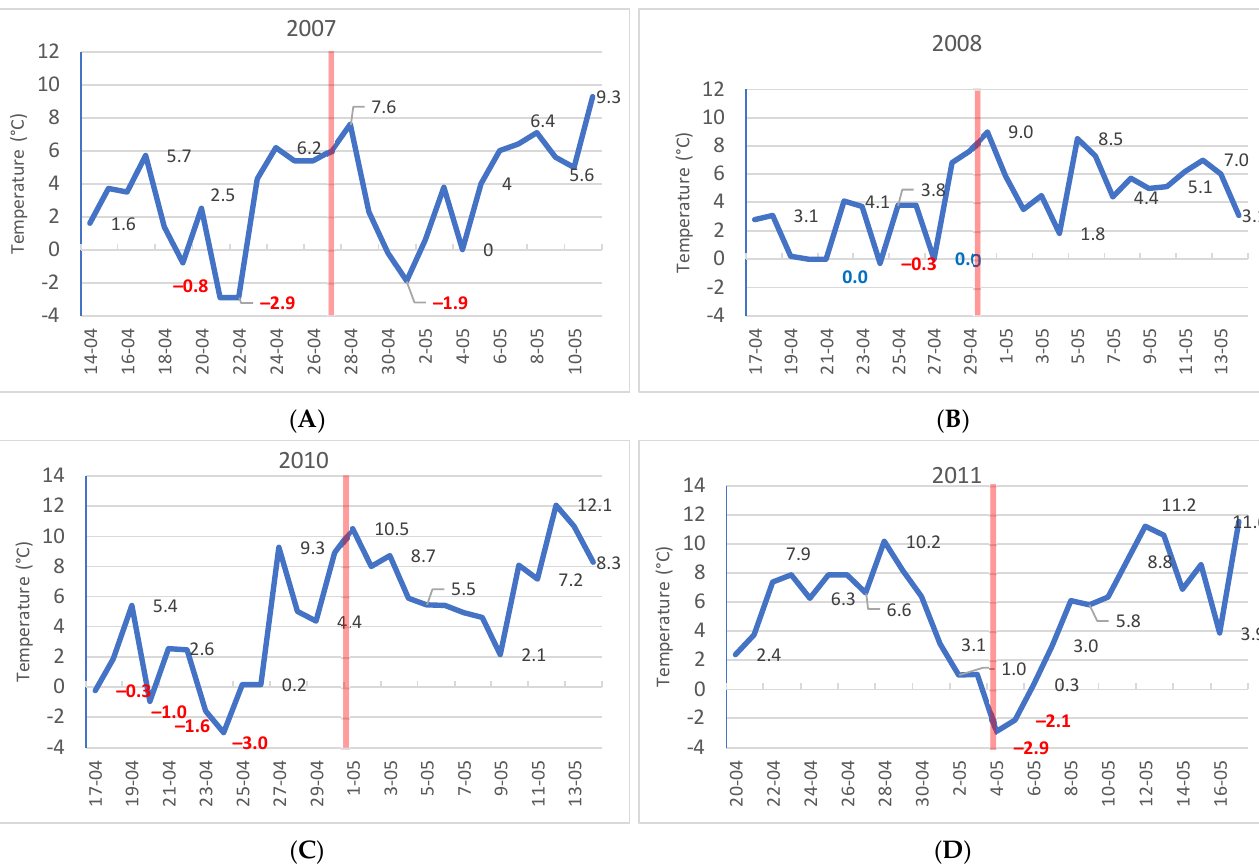
Figure 1. Temperature profiles corresponding to the 2 weeks before and after full flowering in the years of onset of spring frosts. ( A ) 2007, ( B ) 2008, ( C ) 2010, ( D ) 2011.